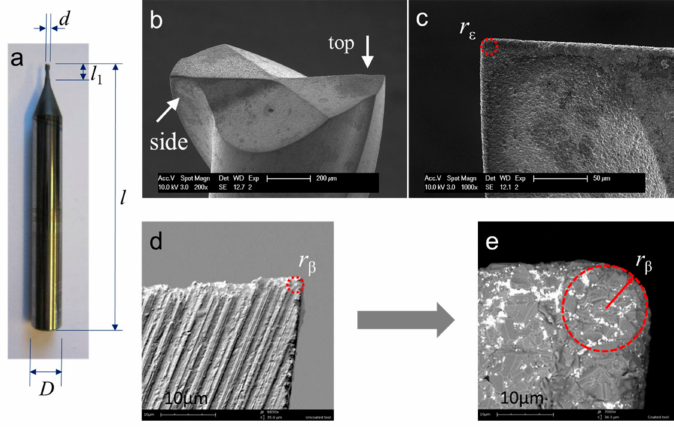
Figure 1. SEM images of the micro end mill: ( a ) overview of the geometry of the end mill; ( b ) top view of the cutting-edge radius; ( c ) side view of the tool tip; ( d ) the original cutting-edge radius before diamond coating; ( e ) the cutting-edge radius after diamond coating.